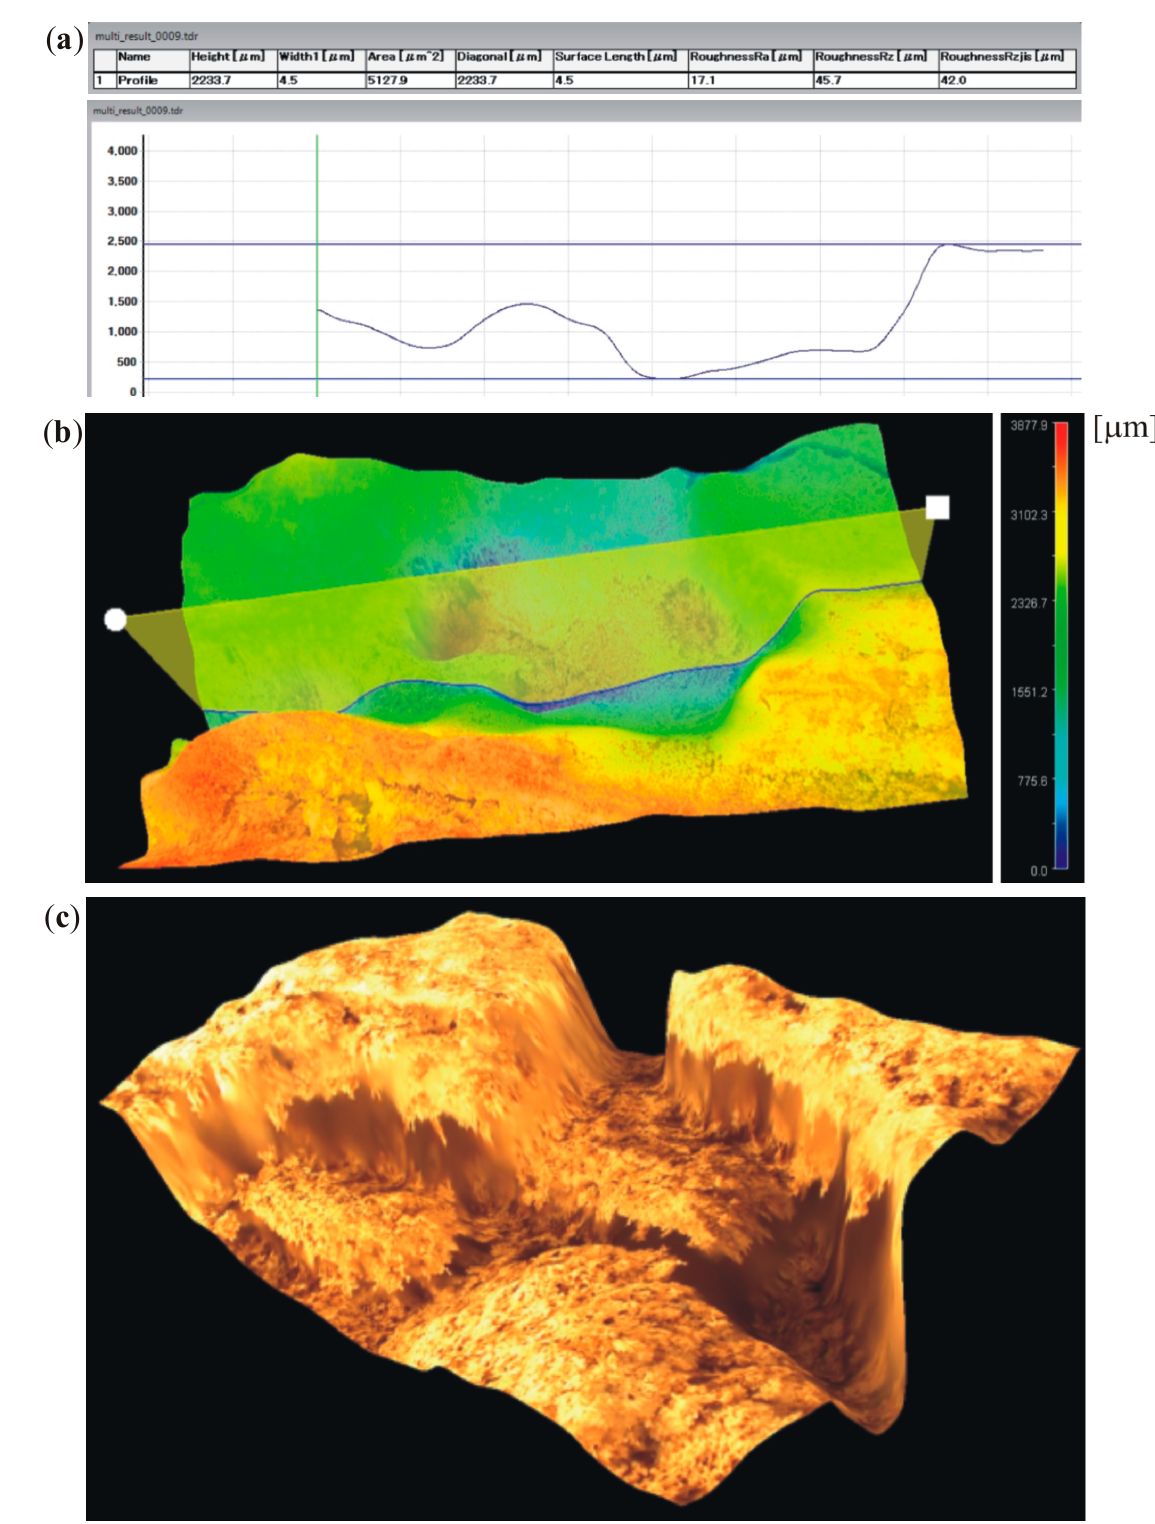
Figure 5. Results of measurement of sediment surface roughness with the use of the HIROX RH-8700 digital microscope: ( a ) table with results of measurement of sediment surface roughness and longitudinal profile of the investigated sediment surface; ( b ) spatial visualization of longitudinal profile of the investigated sediment surface; ( c ) 3-dimensional visualization of the investigated sediment